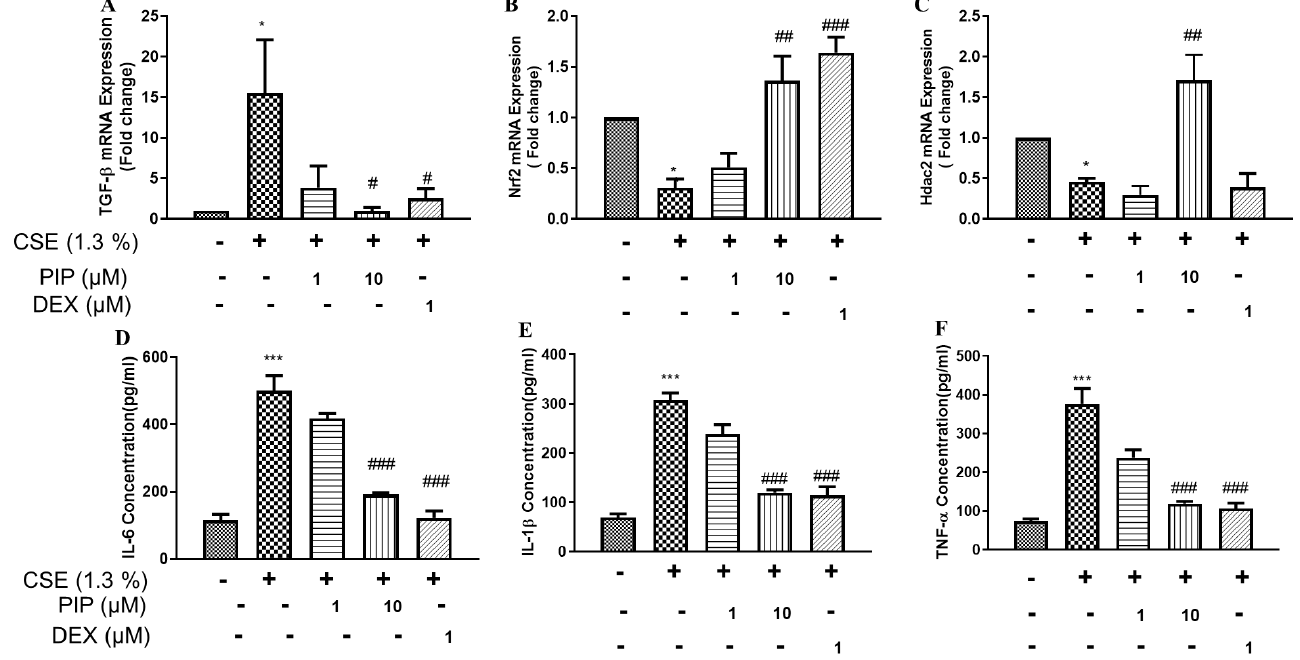
Figure 7. Effect of piperine on CS-induced respiratory functional changes in vivo: ( A ) Mean Pressure- Volume curve at baseline for various groups. Pressure-volume (PV) loops were generated using a ramp-style pressure-volume maneuver (PVr-P). ( B ) Mice were subjected to an increasing dose of nebulized MCh challenge protocol to assess characteristics of airway hyper-responsiveness as central airway resistance (Rn). The values are expressed as mean ± SEM ( n = 6). * p < 0.05, ** p < 0.01 and *** p < 0.001 vs. Veh.control, ## p < 0.01 and ### p < 0.001 vs. CS. Veh.control: Vehicle control, CS: cigarette smoke treated (9 cigarettes per day for 4 days), CS + PIP (1): cigarette smoke + 1 mg/kg PIP, CS + PIP (10): cigarette smoke + 10 mg/kg PIP, CS + DEX (1): cigarette smoke + 1 mg/kg DEX.